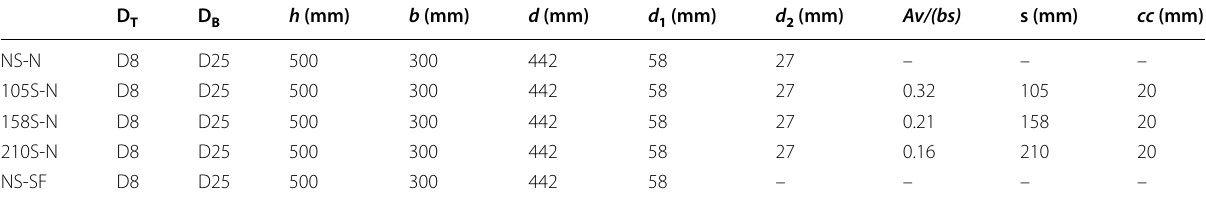
Table 5 Dimensions of reinforced HSC